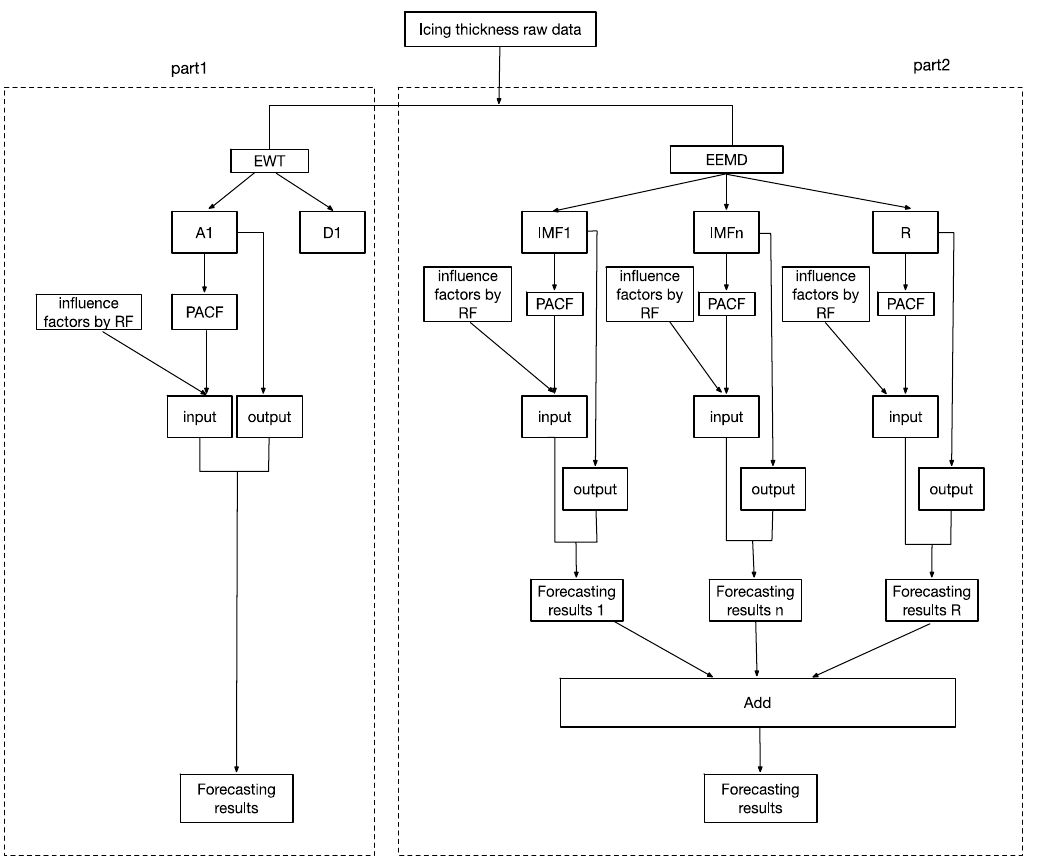
Figure 4. The steps of icing thickness prediction.